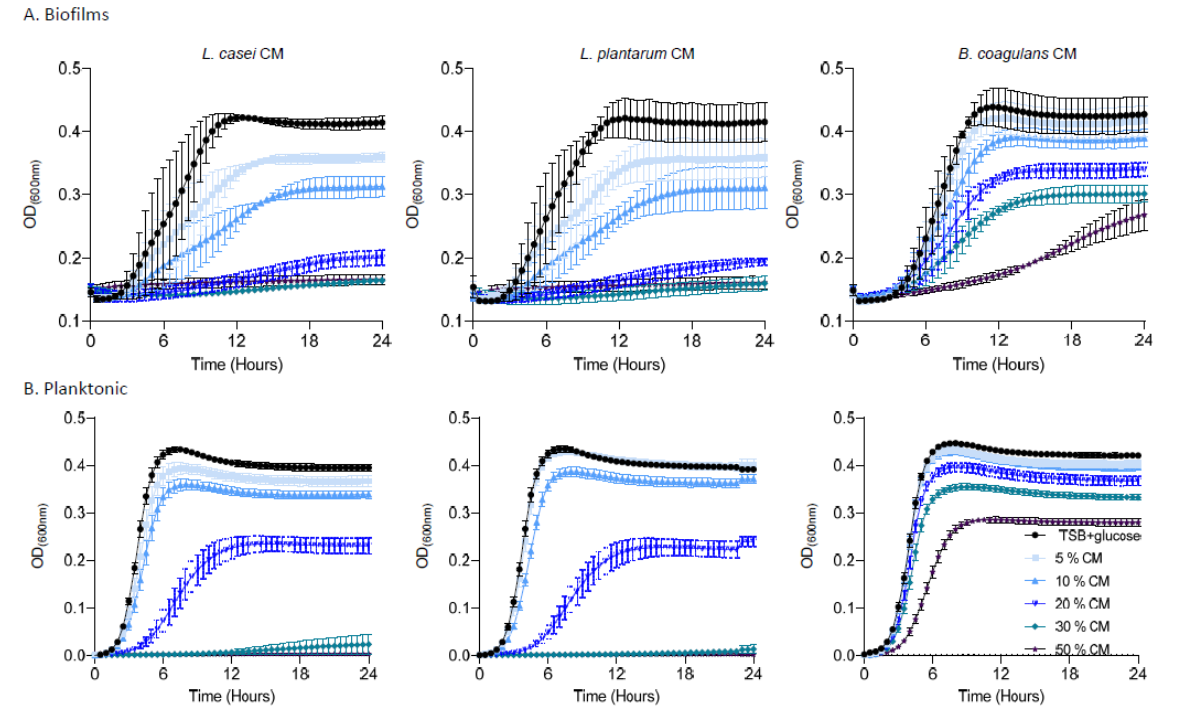
Figure 5. The effect of the secreted products of probiotic strains on E. Faecalis biofilm and planktonic cells. ( A ) Growth of E. faecalis biofilms applied with different concentrations (5%, 10%, 20%, 30%, or 50%) of conditioned medium from either L. casei, L. plantarum, or B. coagulans . Different colors represent the indicated concentrations of the CM. ( B ) Growth of E. faecalis planktonic cells applied with different concentrations (5%,10%, 20%, 30%, or 50%) of conditioned medium from L. casei, L. plantarum, or B. coagulans . Prevention of growth was accomplished by a high concentration of L. casei/L. plantarum with a dose dependent growth reduction. The B. coagulans conditioned medium failed to prevent E. faecalis growth. Graphs represent the mean ± SD from three independent experiments ( n = 9). Statistical analysis was performed using two- way ANOVA followed by Dunnett’s multiple comparison test. p < 0.05 was considered statistically significant.